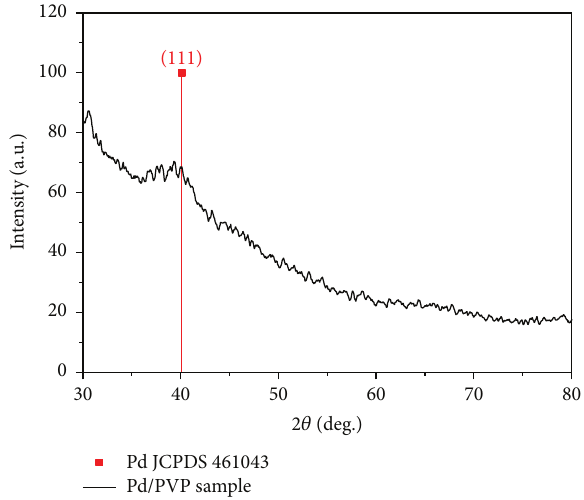
Figure 2: XRD of palladium clusters produced by reduction of [PdCl 4 ] 2− at 90 ∘ C.